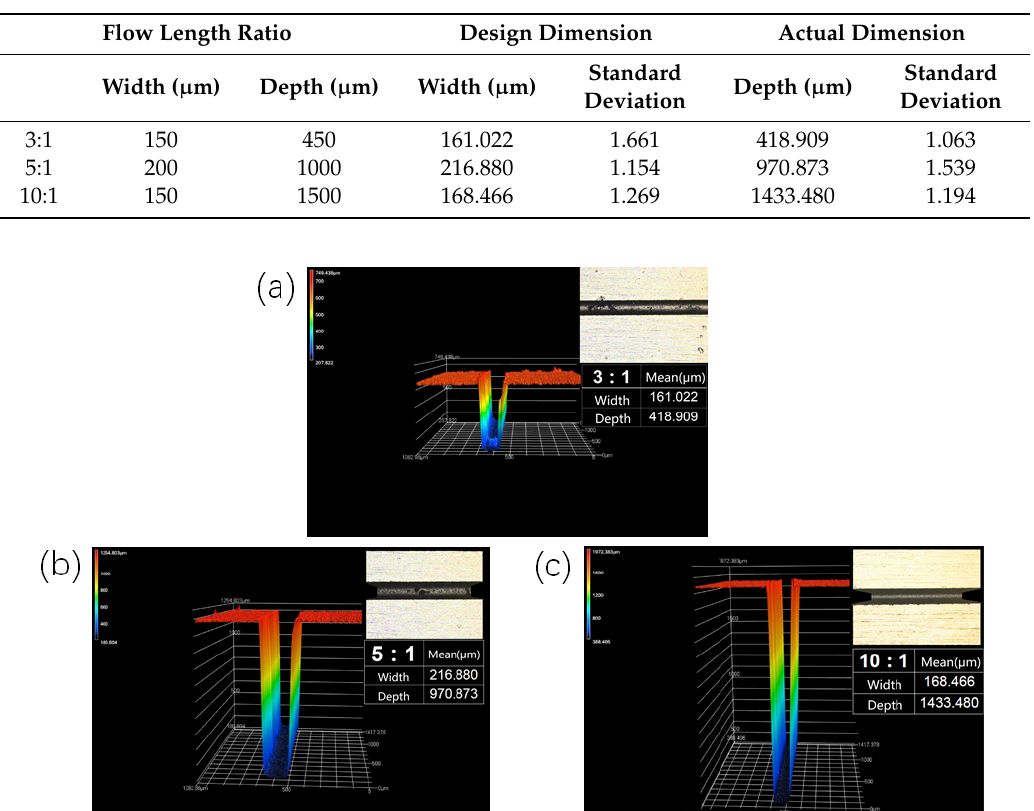
Table 1. Cross-sectional dimensions of the rectangular microgrooves.